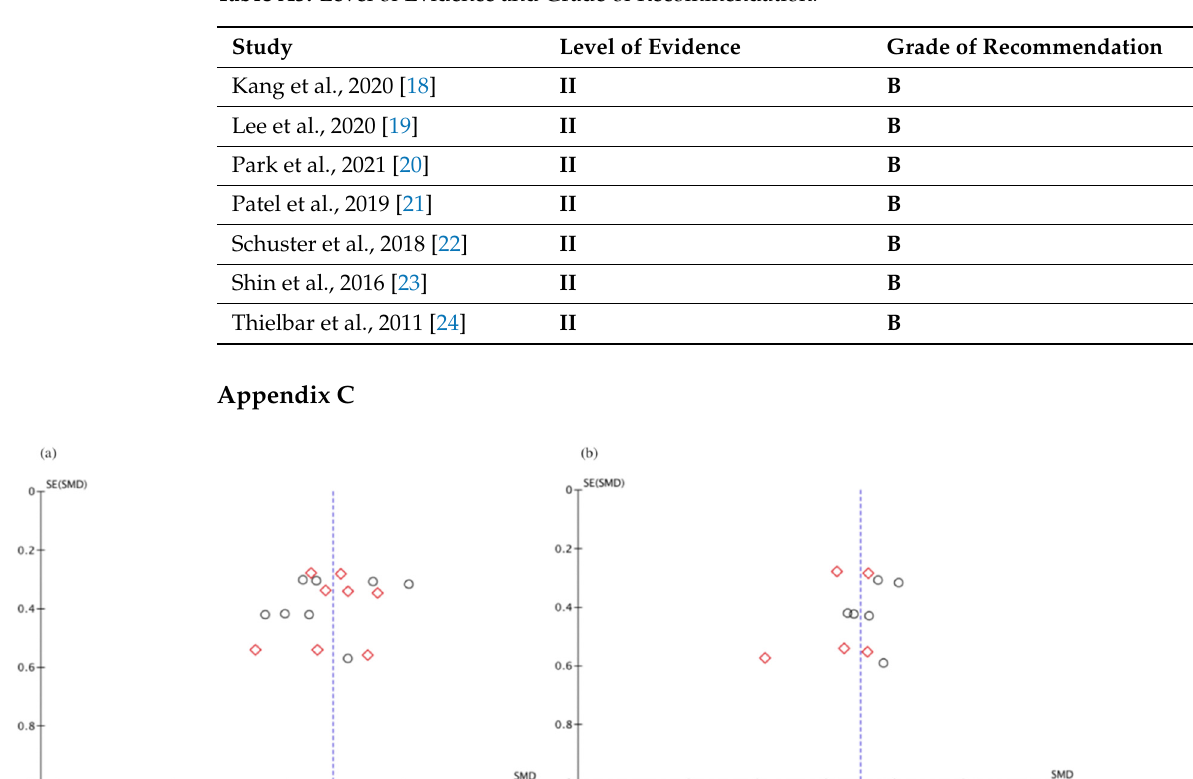
Table A3. Level of Evidence and Grade of Recommendation.